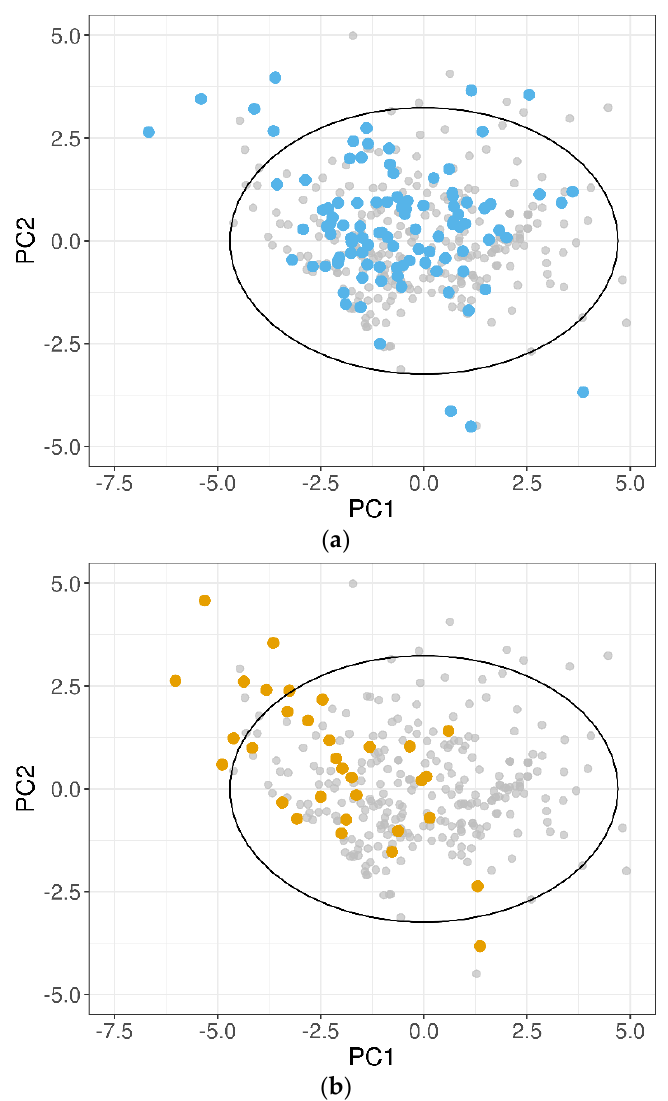
Figure 5. Projections of the ( a ) 100-compound test set 1 (blue dots) and ( b ) 32-compound test set 2 (orange dots) on the two most important PCs of the training dataset. Grey dots show the position of the training compounds. The black solid ellipse marks the 95% confidence interval of the training domain.